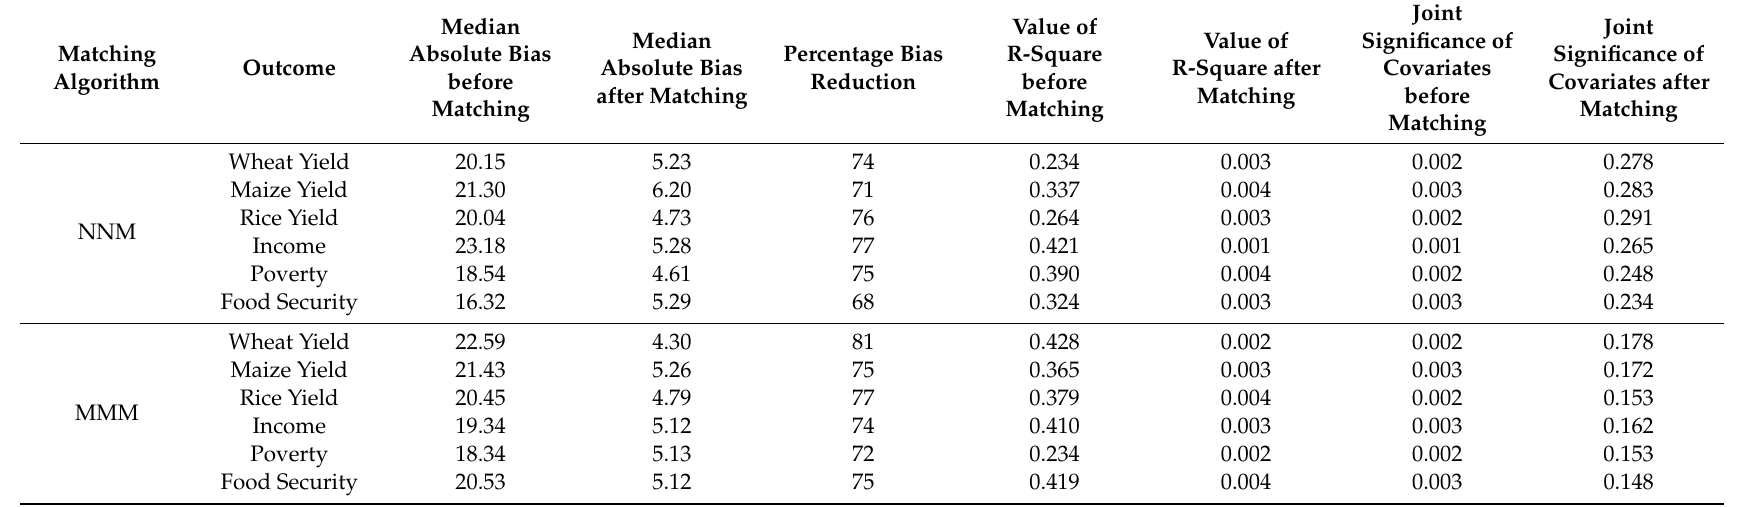
Table 7. Indicators of covariate balancing (before and after